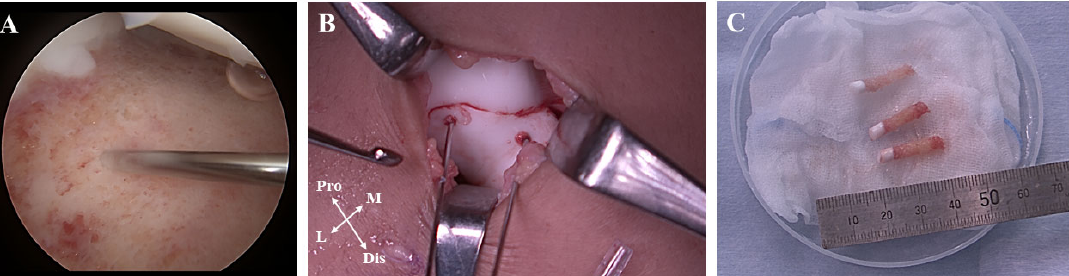
Figure 4. Surgical photographs. After debridement of the lesion in the intercondylar groove with an arthroscopic shaver, bone marrow stimulation was performed with a 1.2 mm Kirschner wire (arthroscopic viewing via the anterolateral portal) ( A ). The detached osteochondral fragment was temporally fixed ( B ). A total of four osteochondral grafts were harvested. However, the cartilage completely detached from one of the four grafts ( C ).